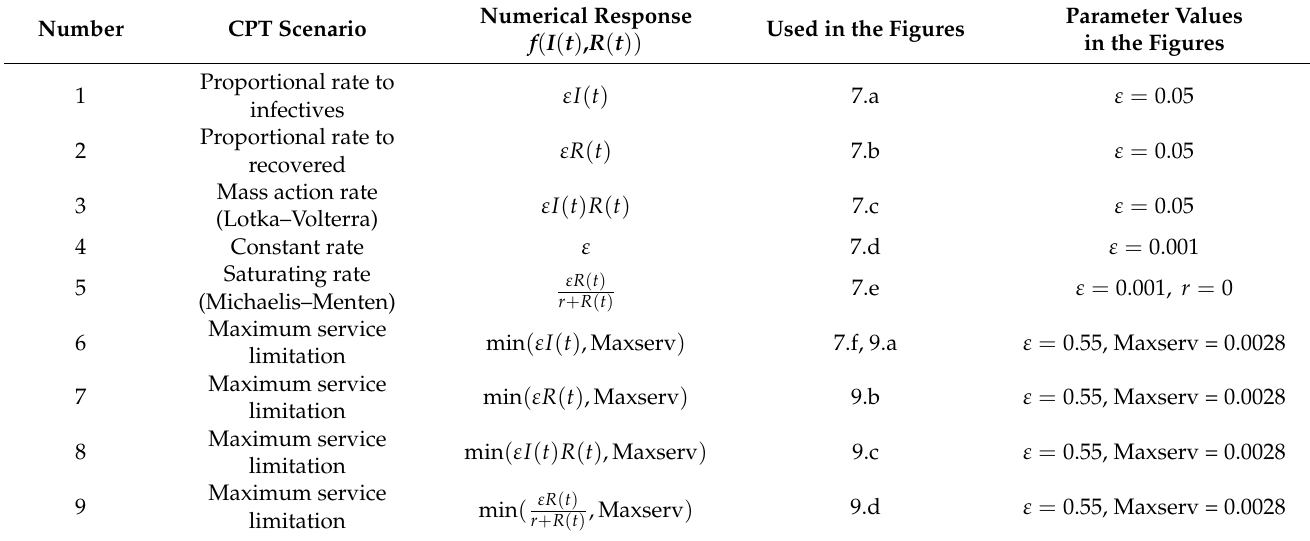
Table 2. Parameter values used for different scenarios of CPT